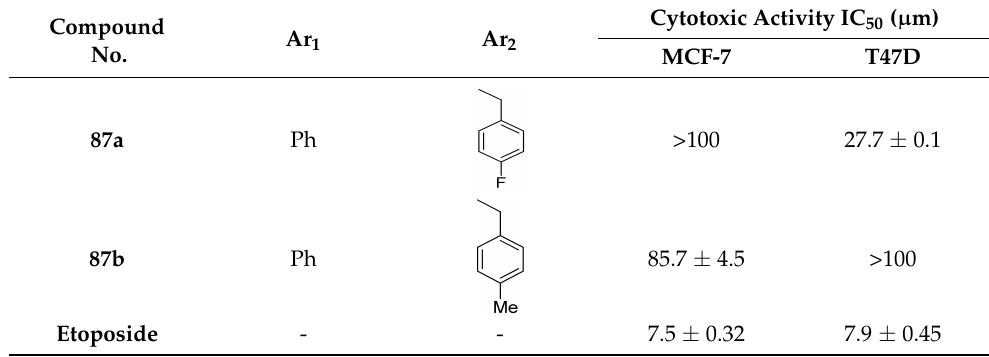
Figure 84. Structure of triazole ‐ isoxazole derivatives ( 87 ).